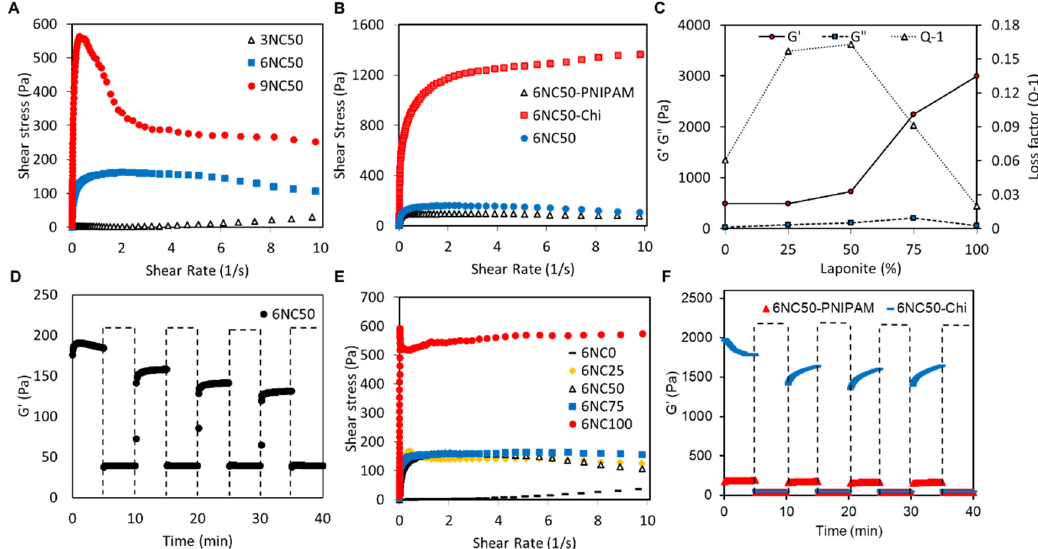
Figure 3. Rheological and mechanical analysis and injectability of shear-thinning hydrogel. Plot of shear stress versus shear rate as a function of ( A ) total solid weight (3NC50, 6NC50 and 9NC50) and ( B ) percentage of Laponite in solid mass (0, 25, 50, 75, and 100); ( C ) storage modulus (G ′ ), loss modulus (G ″ ), and loss factor of 6NCy as a function of Laponite concentration; ( D ) G ′ of 6NC50 after repeated application of high strain (100% strain) and low strain (1% strain) over time (high strain condition is the regions in box); ( E ) plot of shear stress as a function of shear rate for 6NC containing pH sensitive particles; ( F ) G ′ recovery of 6NC-PNIPAM and 6NC50-Chi after subjecting the gels to alternating high strain and low strain condition.